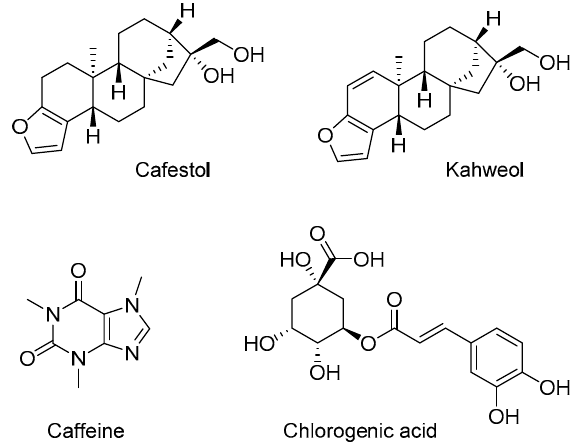
Figure 2. Chemical structures of bioactive compounds found in coffee.